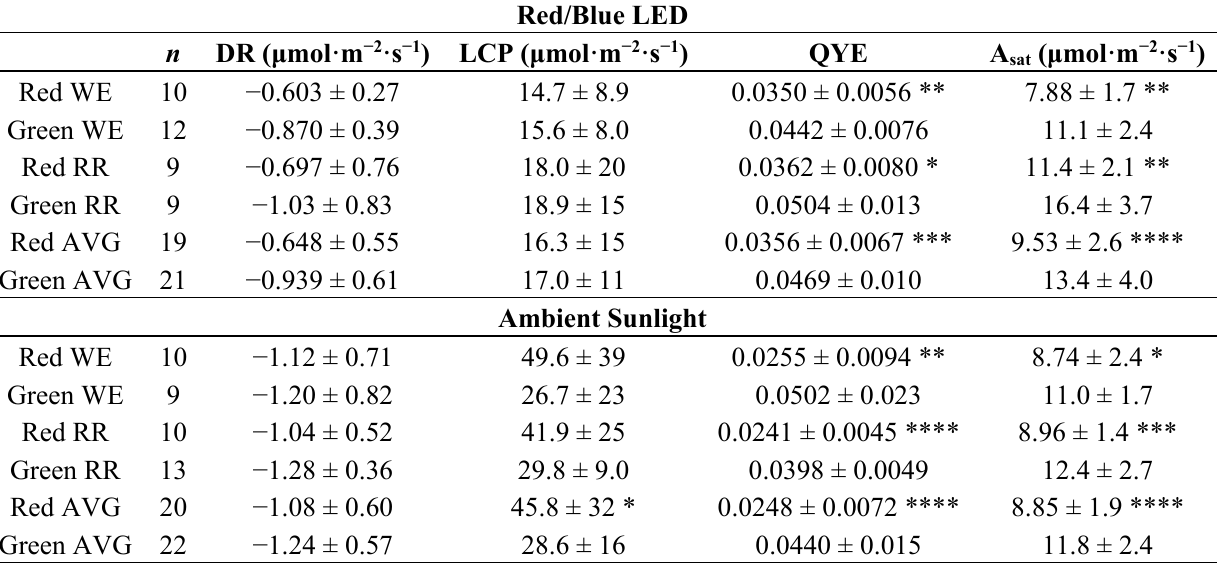
Table 1. Data derived from light response curves for red versus green leaves measured during winters of 2011–2013. Data are means derived during winter at West End (WE) and Railroad (RR) field sites, using either red/blue LED as a light source, or ambient sunlight. Data include: dark respiration rate (DR), light compensation point (LCP), quantum yield efficiency (QYE), and photosynthesis under saturating irradiance (A sat ). Asterisks denote statistical significance between means (±SE) of red and green leaves at each site (* p < 0.05, ** p < 0.01, *** p < 0.001, **** p <